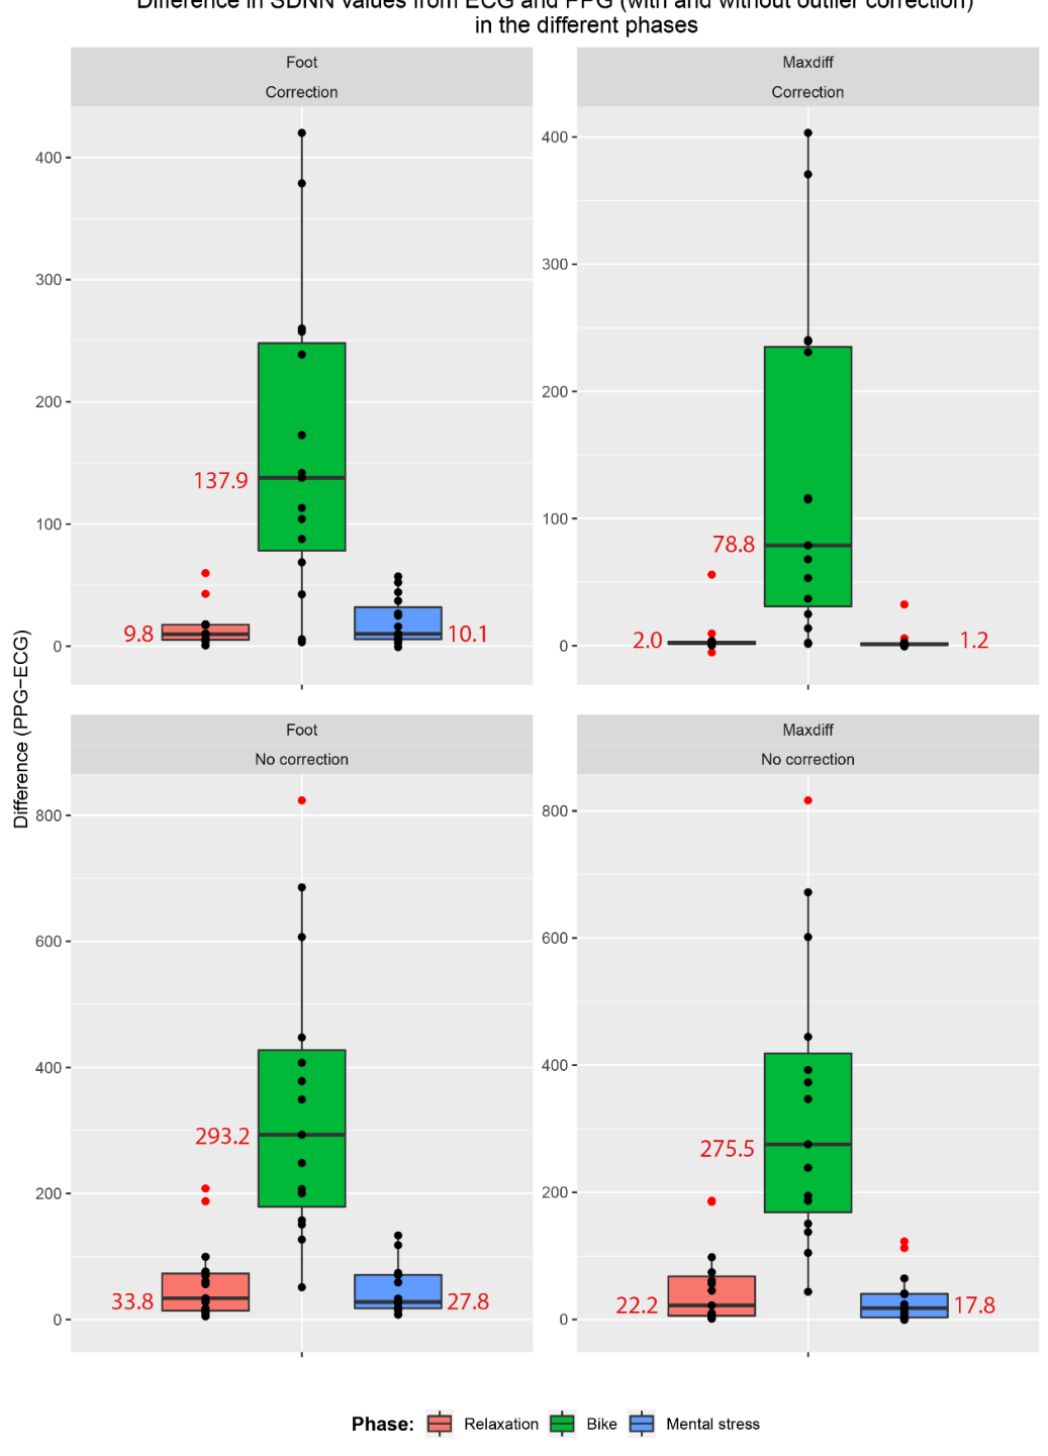
Figure 9. The difference between SDNN values as calculated from PPG and ECG for the 15 participants in the different phases. Grouped by fiducial point and outlier correction. Outliers and median values are shown in